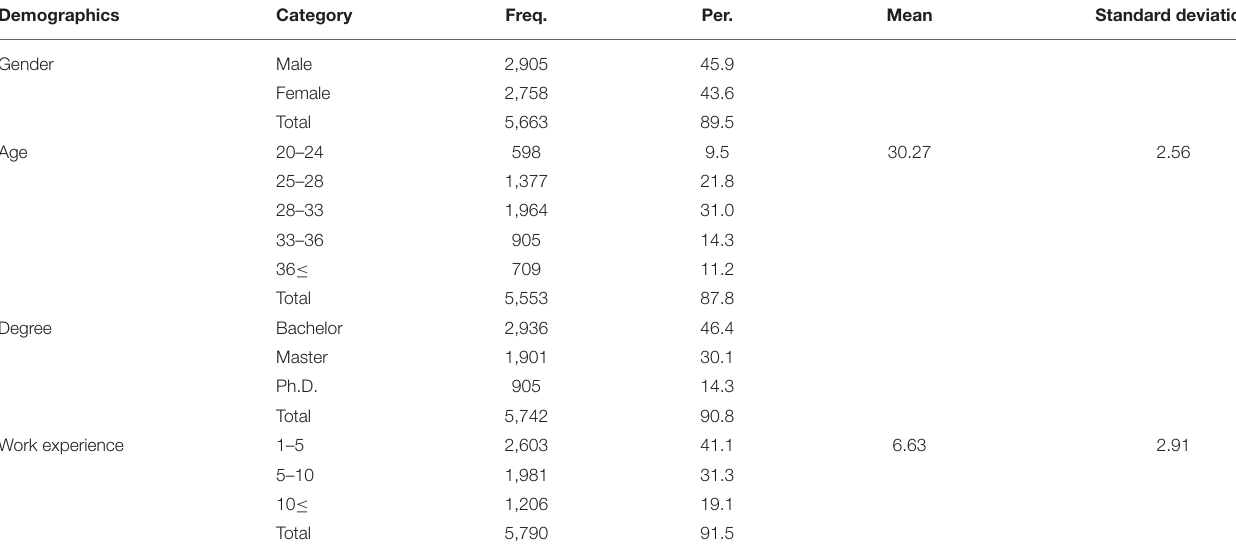
TABLE 2 | Demographic information of the questionnaire sample. Demographics Category Freq. Per. Mean